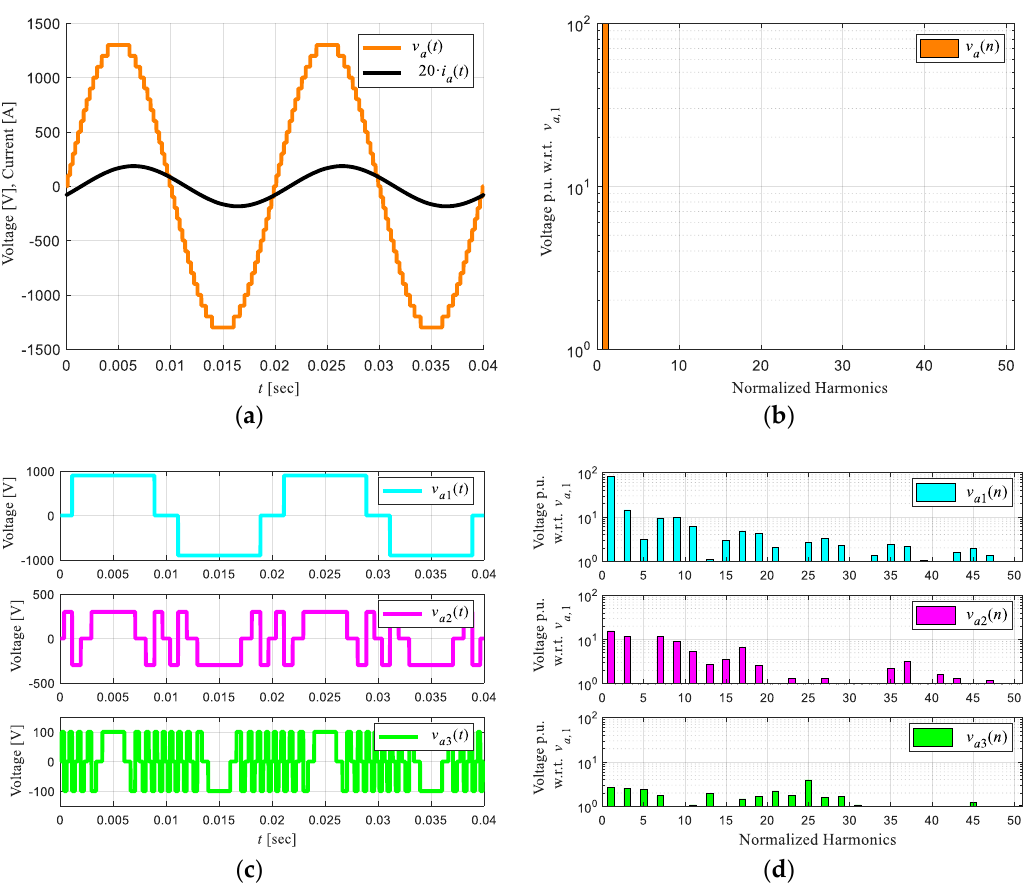
Figure 8. Simulation results 27 levels single-phase asymmetric Inverter without regeneration for m = 1.0. ( a ) Output voltage and current, ( b ) Harmonic spectrum for output voltage v a ( t ), ( c ) Individual inverter output voltages, ( d ) Harmonic spectrum v a 1 ( n ), v a 2 ( n ), and v a 3 ( n ).